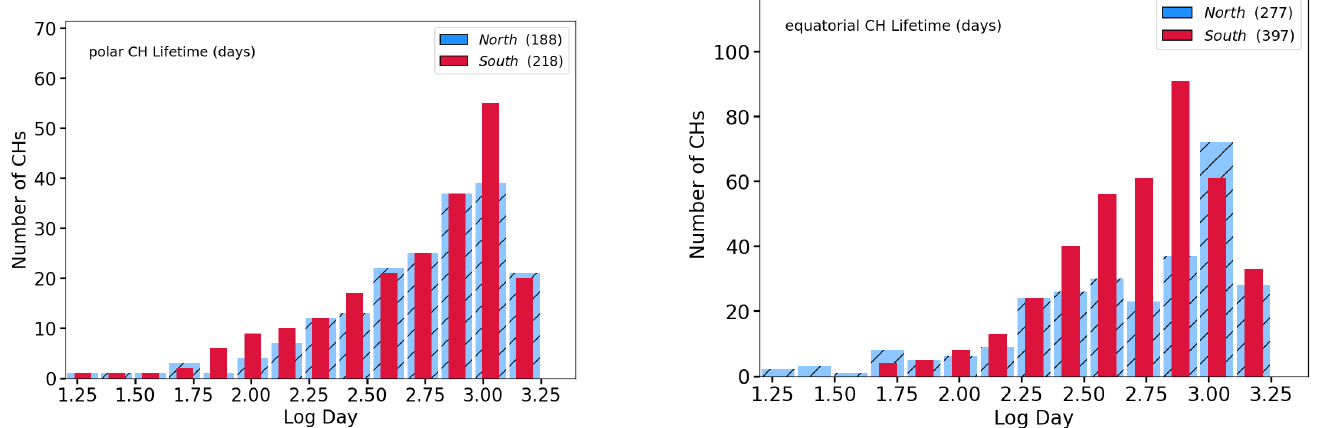
Figure 3. The ( left-hand ) histogram shows the lifetime distribution for the polar coronal holes. The ( right-hand ) histogram shows the lifetime distribution for the equatorial coronal holes. The num- ber of coronal holes in each considered zone is indicated in